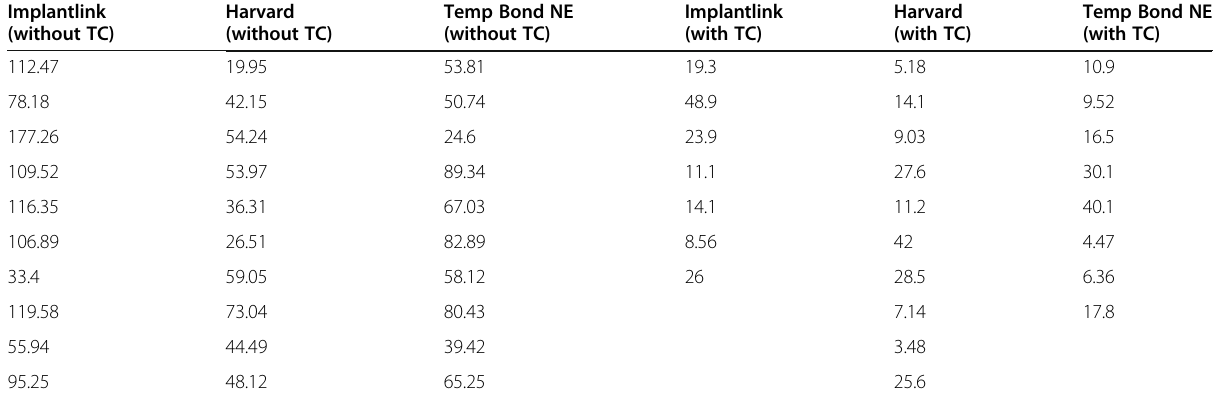
Table 2 Pull-off forces in Newton (N) for each temporary cement per specimen before and after TC, fail outs were observed for Implantlink and Temp Bond NE with TC Implantlink Harvard (without TC) (without TC)